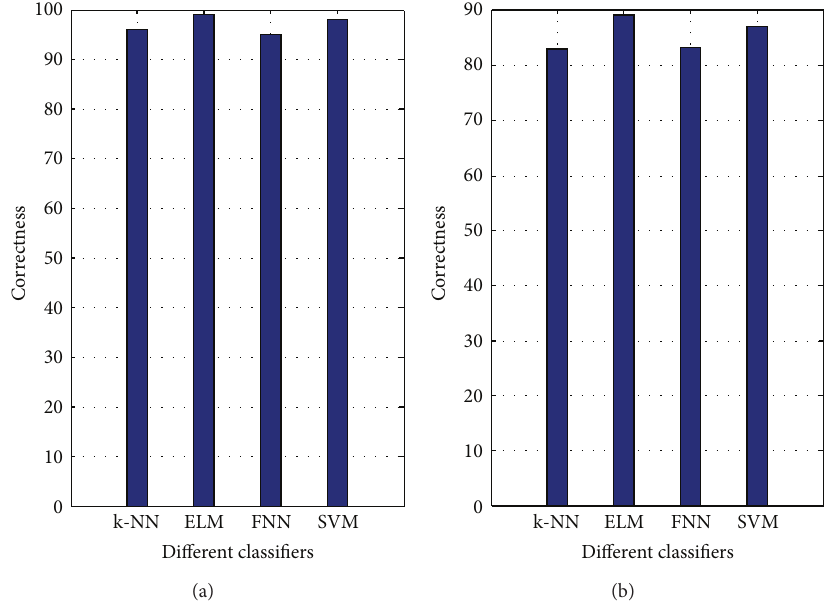
Figure 9: Performance comparison for k-NN, ELM, FNN, and SVM classifiers: the color FERET database: (a) fb subset and (b) dup1